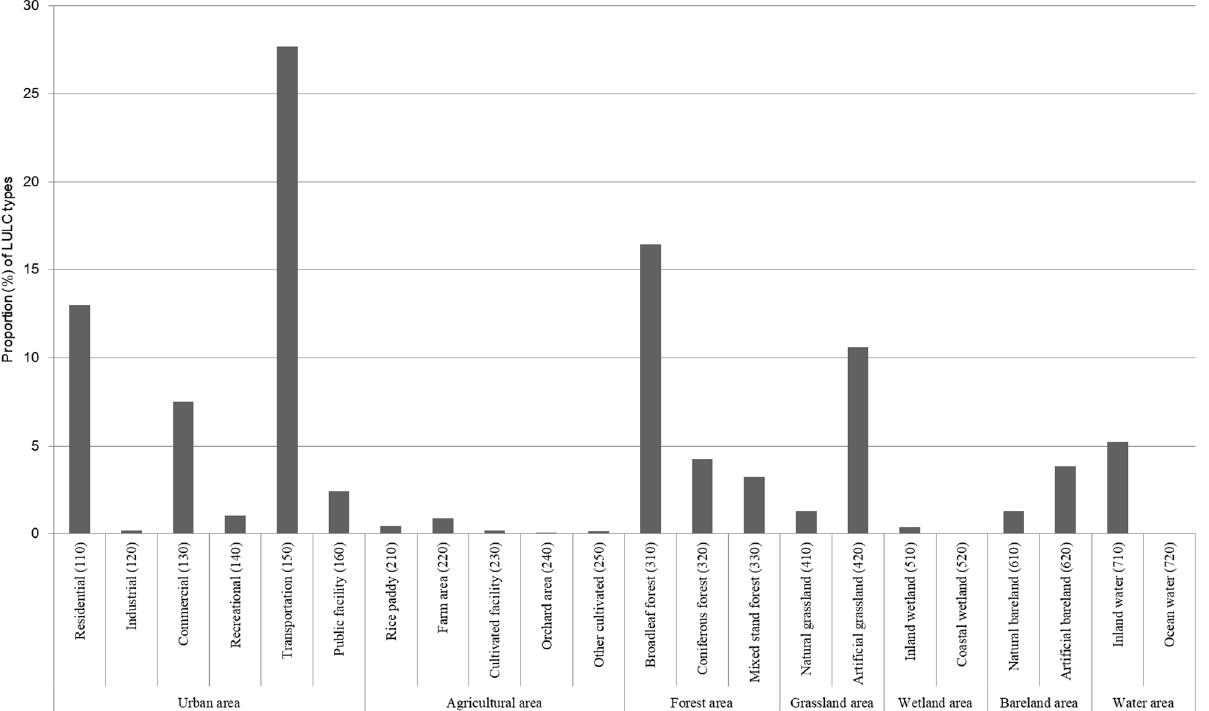
Table 3. Parameters of XGBoost model.